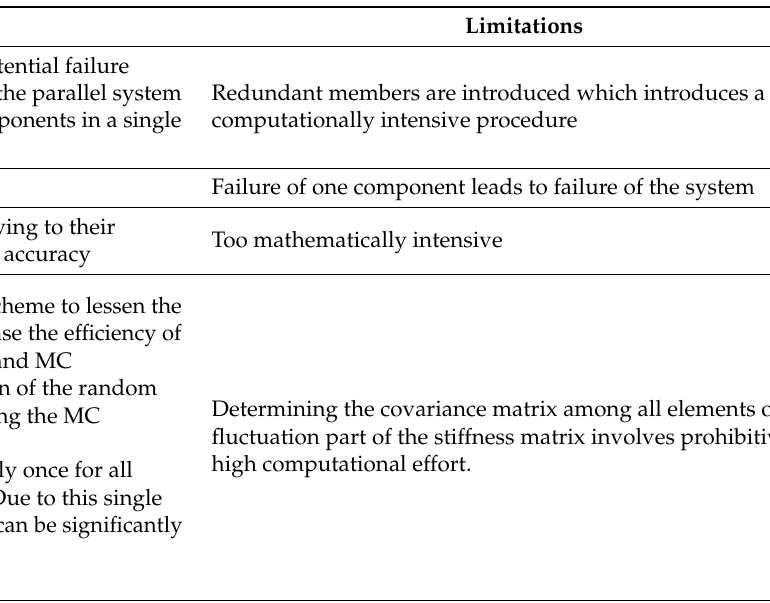
Table 3. Capabilities and limitations of the most common advanced approximation structural reliability